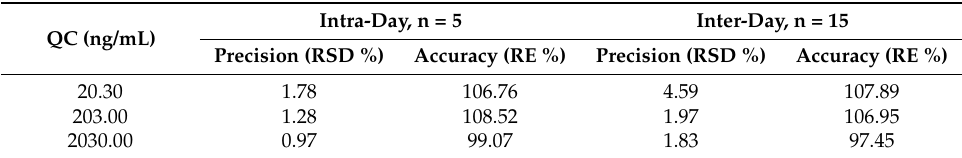
Table 2. Precision and accuracy of Nec-1s in rat plasma (analysis of QC samples).